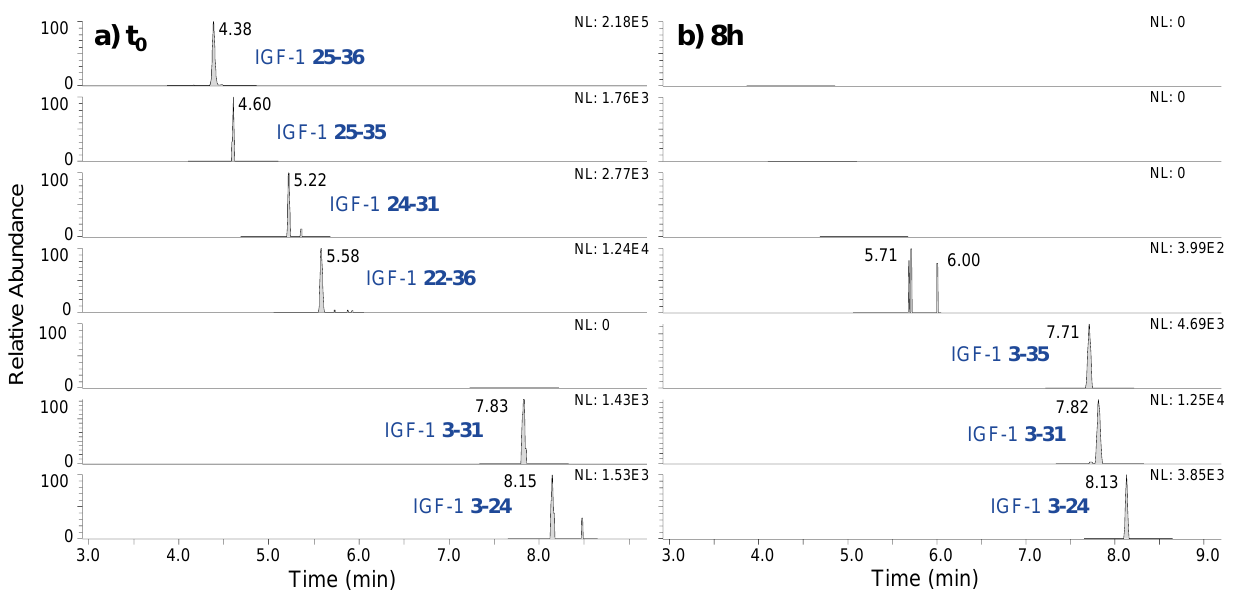
Figure 7. Extracted ion chromatograms of IGF-I metabolites generated by incubation in skin S9 mix over 2 h ( a ) before and ( b ) after another incubation in human serum over 8 h to assess stability.